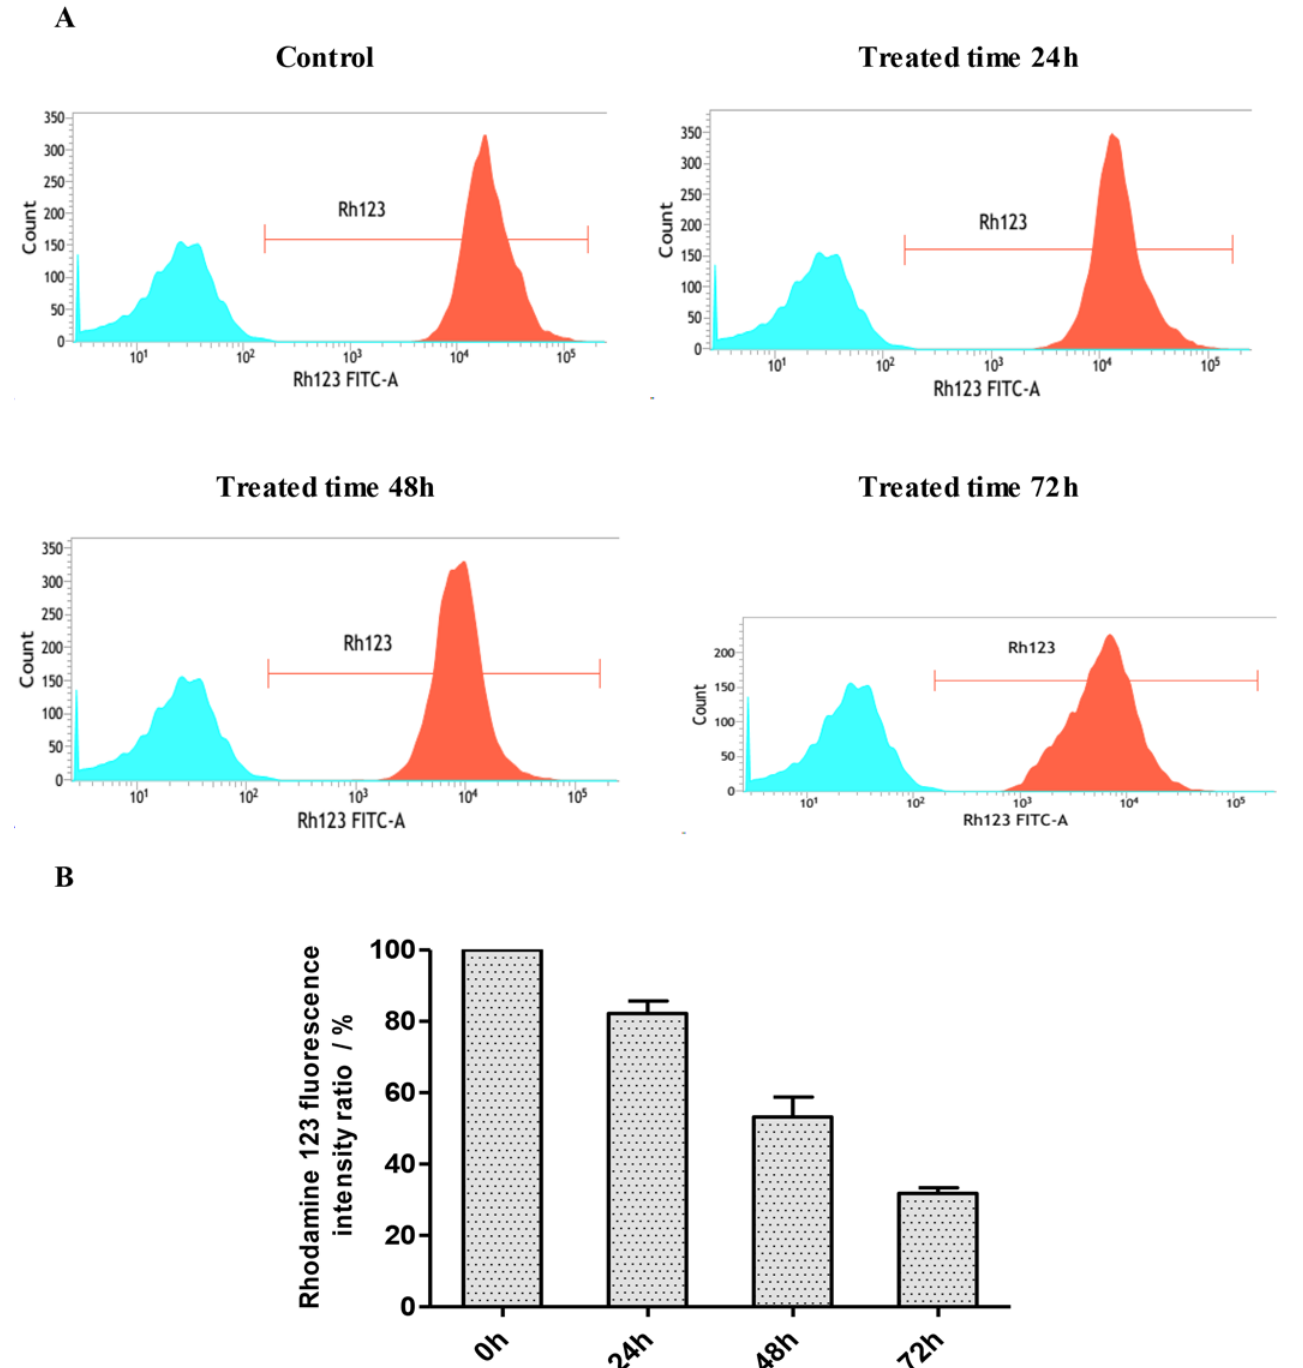
Fig 10. Effects of EM-d-Rha on HepG2 mitochondrial membrane potential ( ΔΨ m) in different treated times. ΔΨ m was detected by flow cytometry. A: HepG2 cells were incubated with 5 μ M EM-d-Rha for 0, 24h, 48h and 72h respectively. B: Data pooled from three replicates show the percentage of HepG2 ΔΨ m vs . control group. The error bars represent mean ± standard deviation. Difference was considered statistically significant when * p < 0.05 and ** p < 0.01 vs . control group .